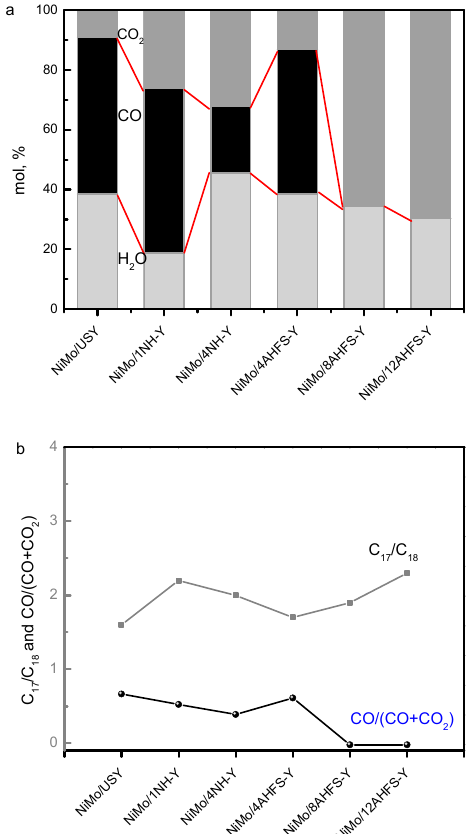
Figure 5. ( a ) Distribution of H 2 O, CO, CO 2 products and ( b ) the variation of C 17 /C 18 and CO/(CO + CO 2 ) in the conversion of WCO over different catalysts.